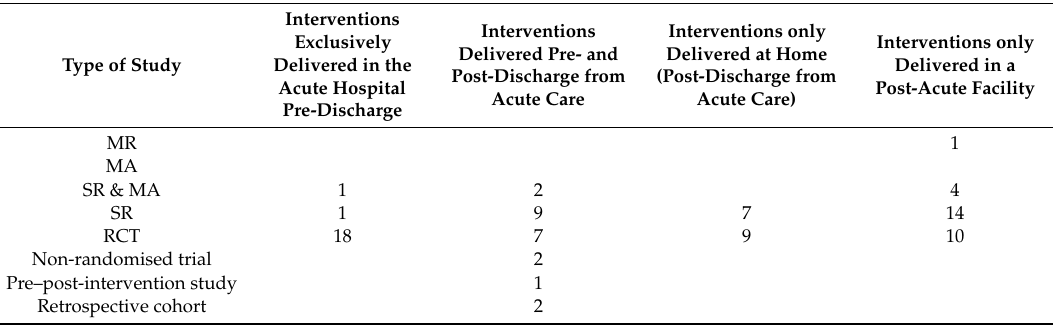
Table 1. Types of